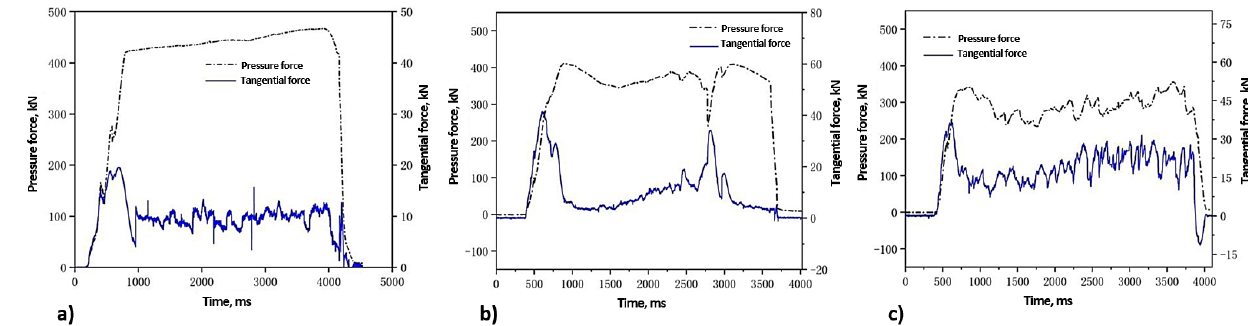
Figure 10. Results of applying HPW jets in the process of mining with a disk tool: the value of pressure force Pd; ( a )—without HPW, ( b )—with HPW—slots distance 81 mm, slots depth 4 mm, ( c )—with HPW—slots distance 81 mm, slots depth 6 mm, (according to [21]).